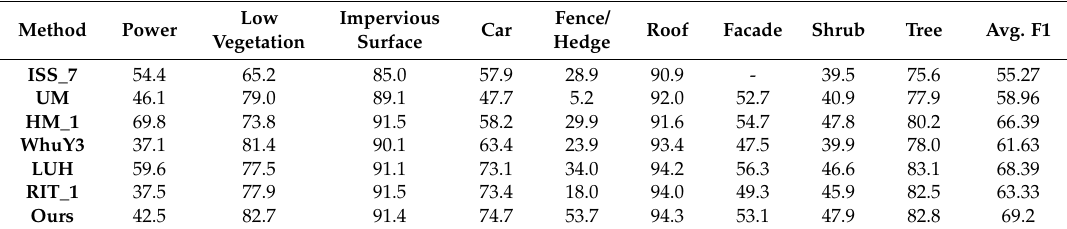
Table 6. A quantitative comparison between the per-class F1 score and the average value of our method and other published methods on the ISPRS test